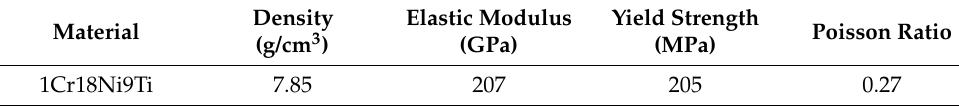
Table 3. Main constitutive parameters [23].